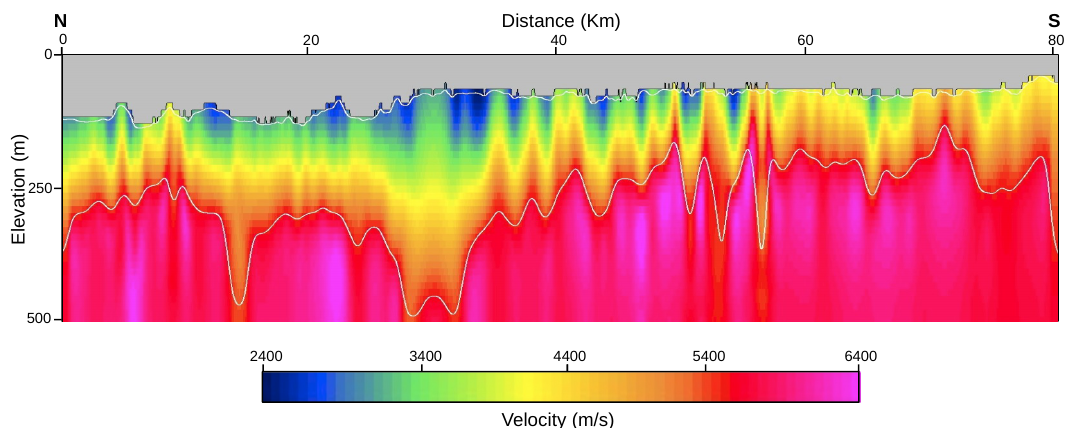
Figure 6. Near-surface velocity model for Swayze R1 survey estimated using refraction